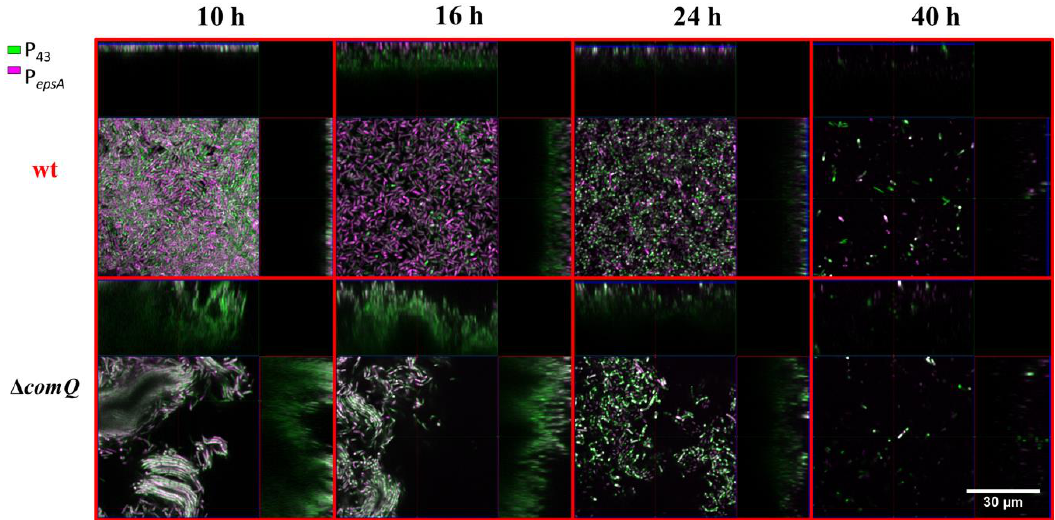
Figure 3. Pellicle biofilms of the PS-216 Bacillus subtilis wild type (wt; BM1631) and the QS mutant ( Δ comQ; BM1622) phenotypes carrying P 43 - mKate2 (false-colored green) and P epsA - gfp (false-colored magenta) transcriptional reporters during static growth in MSgg medium at 37 °C and visualized under a confocal microscope at the indicated time points.